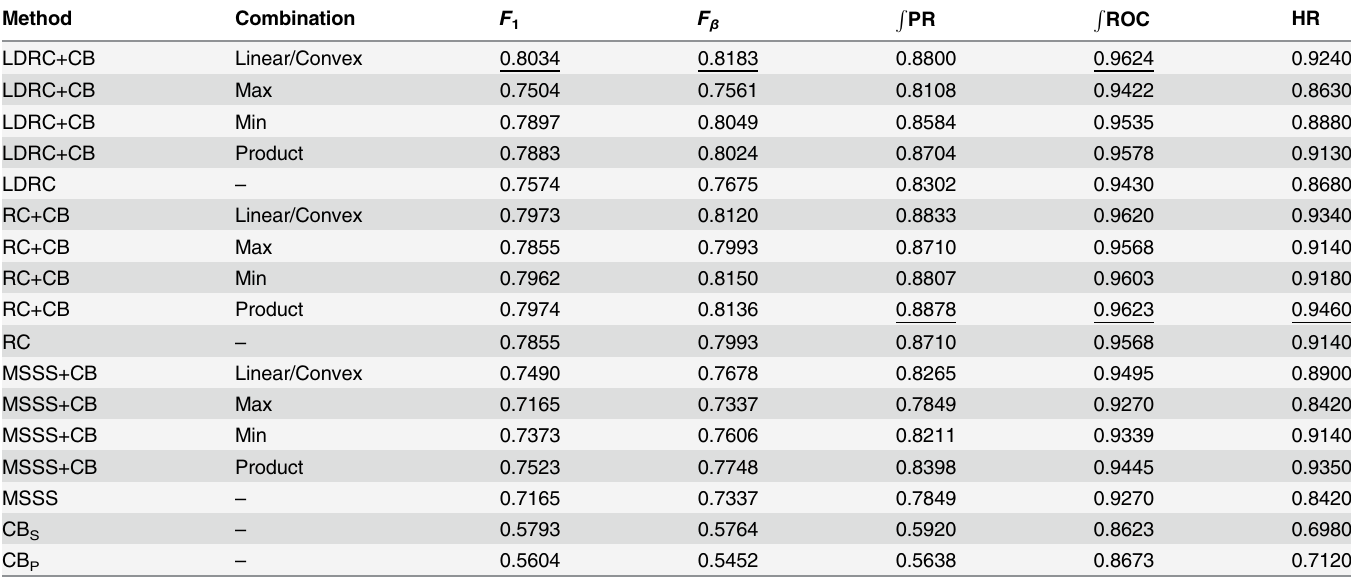
Table 1. The maximum F 1 score, maximum F β score, PR AUC ( tion